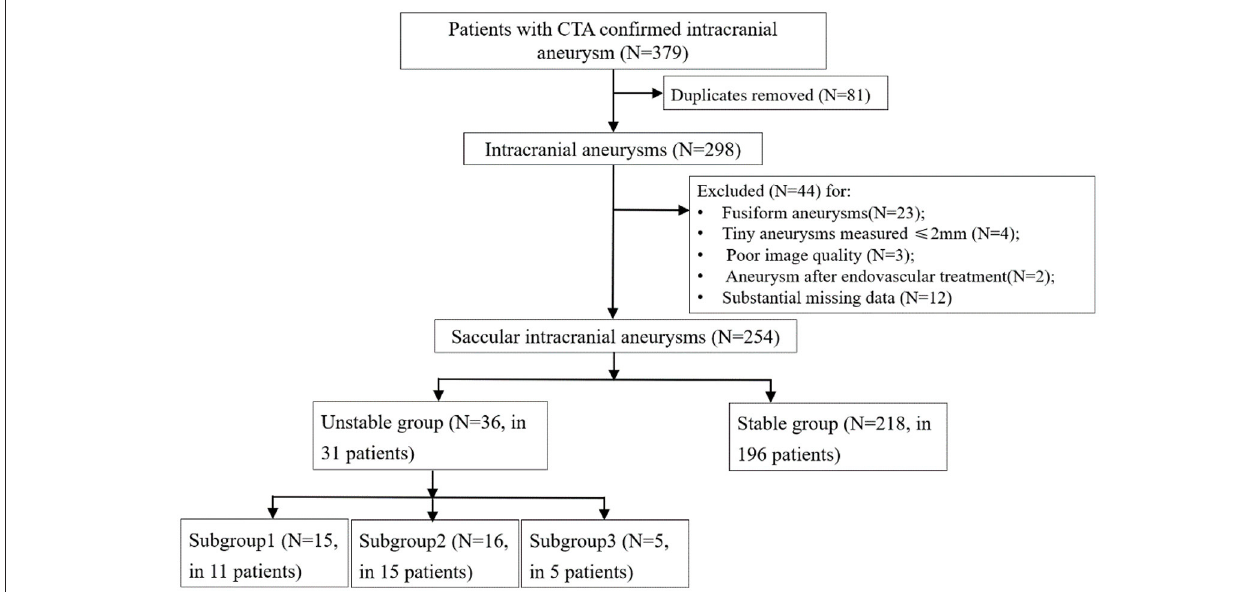
FIGURE 1 | Flowchart of the patients’ inclusion and exclusion process. Subgroup1, aneurysms with a ruptured post-imaging; Subgroup2, aneurysms with growth on serial imaging; Subgroup3, aneurysms with compressive